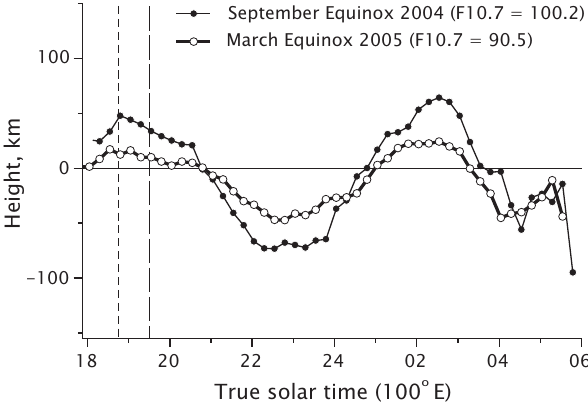
Fig. 2. Double differentials of height deviation from the no-wind reference at the conjugate points for one-month periods centered on the equinoxes of September 2004 and March 2005. Height in km is read as wind velocity in m/s, and the positive sign corresponds to the northward